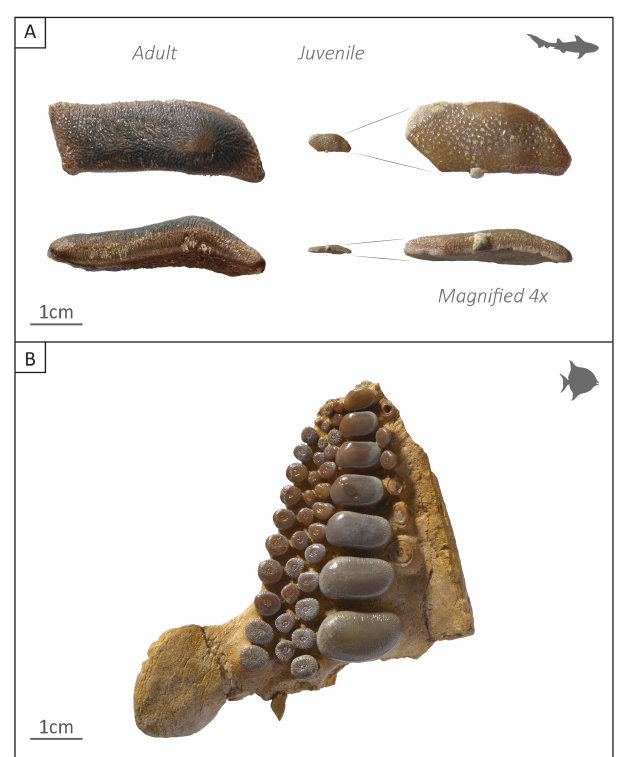
Figure 3. Fossil material from the study site of Porrentruy. (a) : teeth of Asteracanthus . Left: adult specimen (SCR010-1125). Right: ju- venile specimen (SCR004-221) to scale and magnified. Occlusal (top) and lateral (bottom) views. (b) : left prearticular bone of Py- cnodontiformes with teeth (specimen SCR010-1204). Photographs by PAL